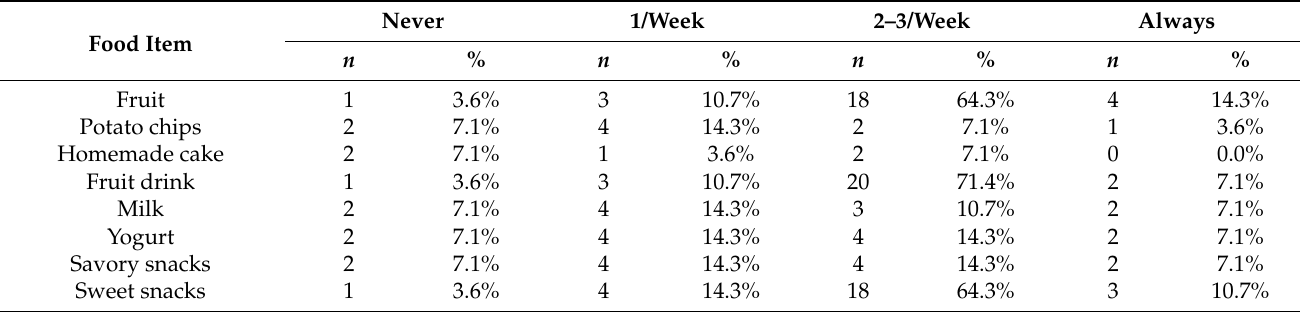
Table 3. Consumption of the 8 food items included in the short food frequency questions